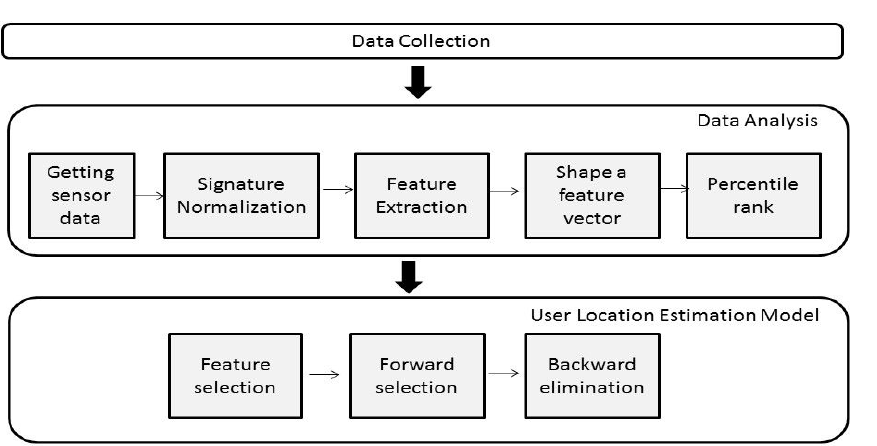
Figure 1. Methodology for estimating the user